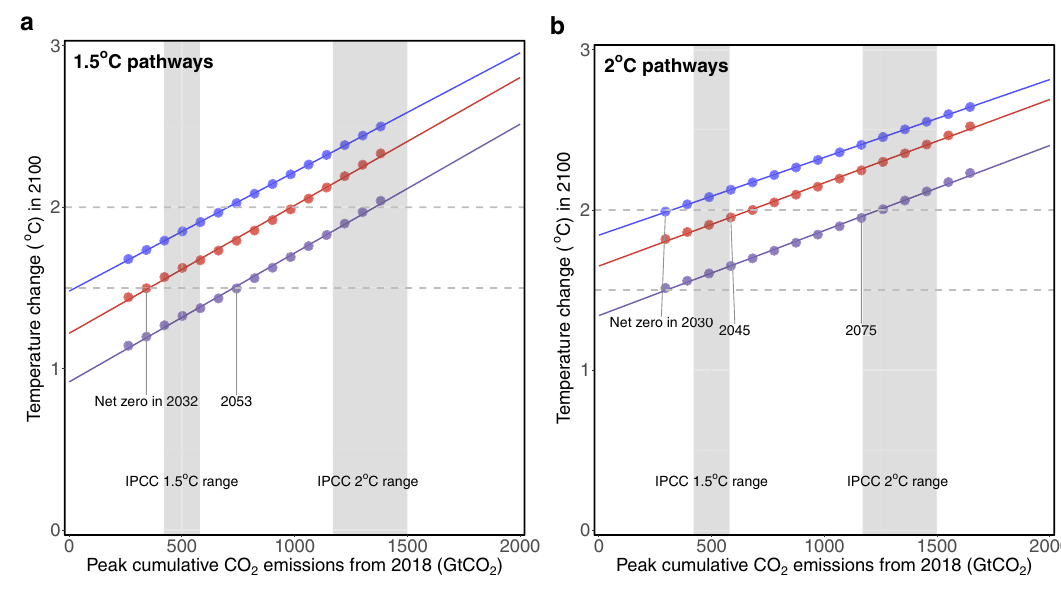
Fig. 1 Transient climate response to cumulative emissions of CO 2 for different non-CO 2 abatement levels. a 1.5 °C pathways and ( b ) 2 °C pathways, assume CO 2 emissions linearly reduce to − 8 and 0 GtCO 2 yr − 1 and stay constant, correspondingly. CO 2 abatement only assumes the same non-CO 2 emissions as the Reference scenario while reducing CO 2 emissions alone; CO 2 -driven GHG abatement includes CO 2 abatement and the non-CO 2 abatement associated with fuel switching and demand reduction driven by CO 2 abatement; Comprehensive GHG abatement additionally considers various non-CO 2 abatement options based on their technical feasibility and cost-effectiveness. For ( a ) net-zero years are interpolated based on the linear CO 2 emission trajectories.